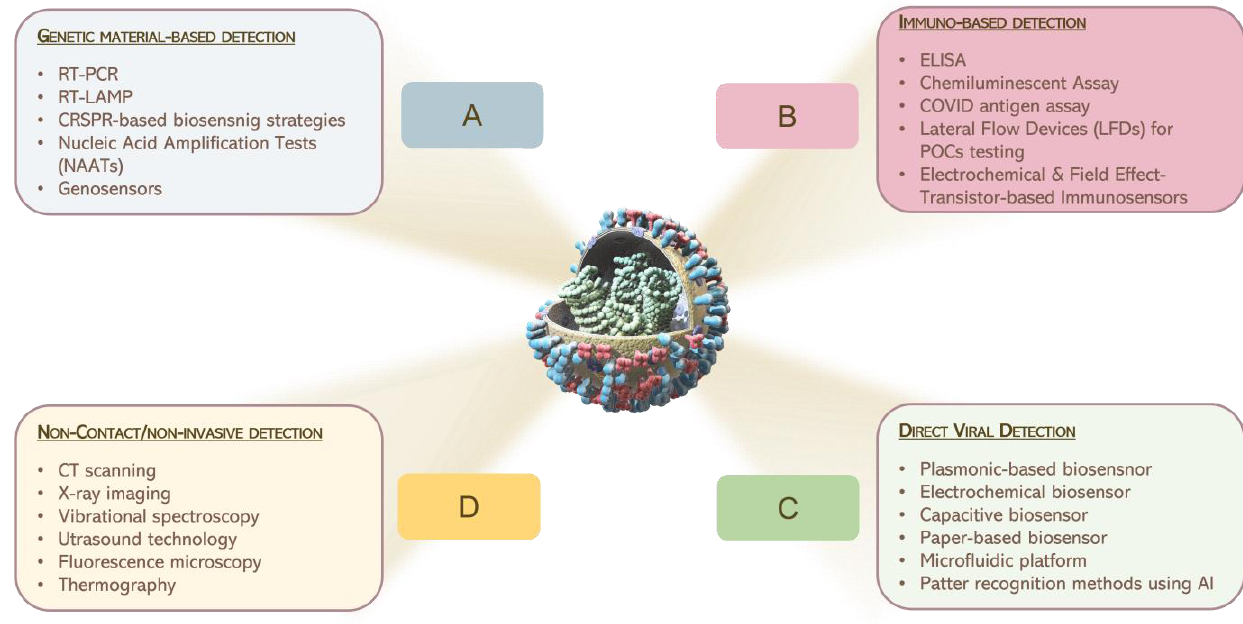
Figure 2. Graphical illustration of the main consolidate processes for the detection of pathogens, currently in use.